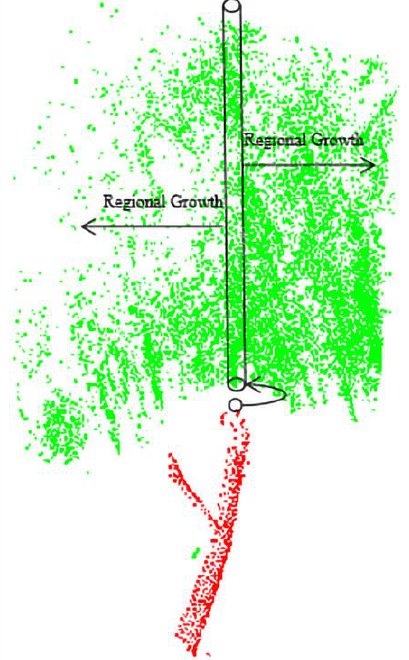
Figure 4. RG algorithm with optimized seed points method (red points represent trunk points, green points are tree crown points, the red point in the black circle is the top point of the trunk, the set of points in the the black cylinder are candidate seed points, and the arrows on the cylinder represent the subsequent growth direction of the candidate points).